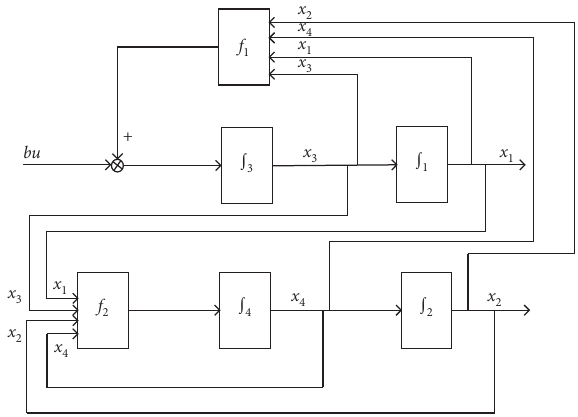
Figure 2: The schematic diagram of the integrator